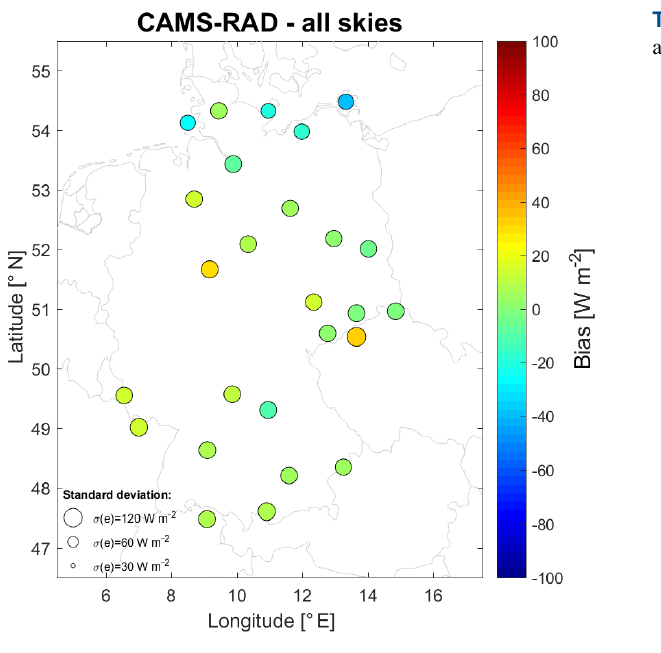
Figure 3. Map of the bias (colour) and standard deviation (diameter of circle) for CAMS-Rad for all skies conditions at the 26 selected stations.